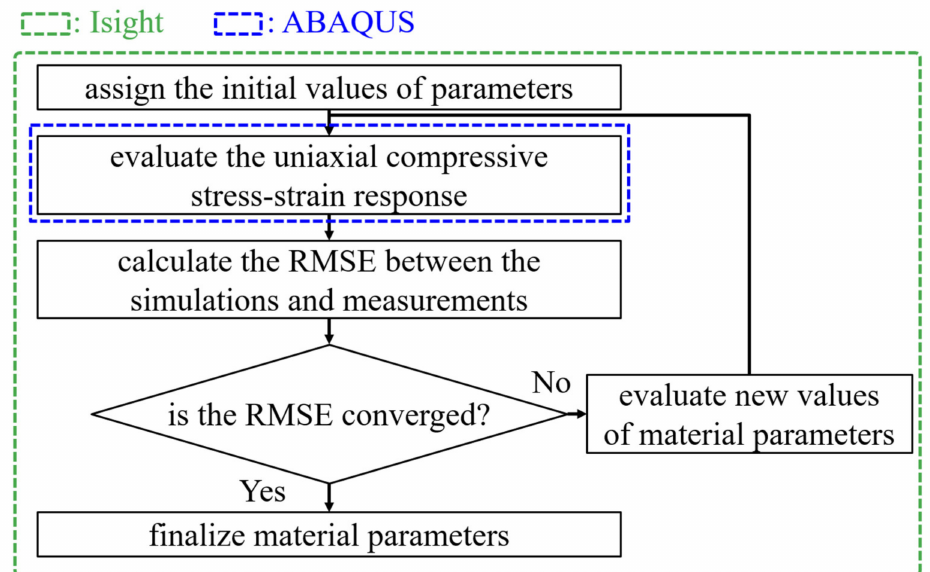
Figure 7. A flowchart of the evaluation of material parameters.